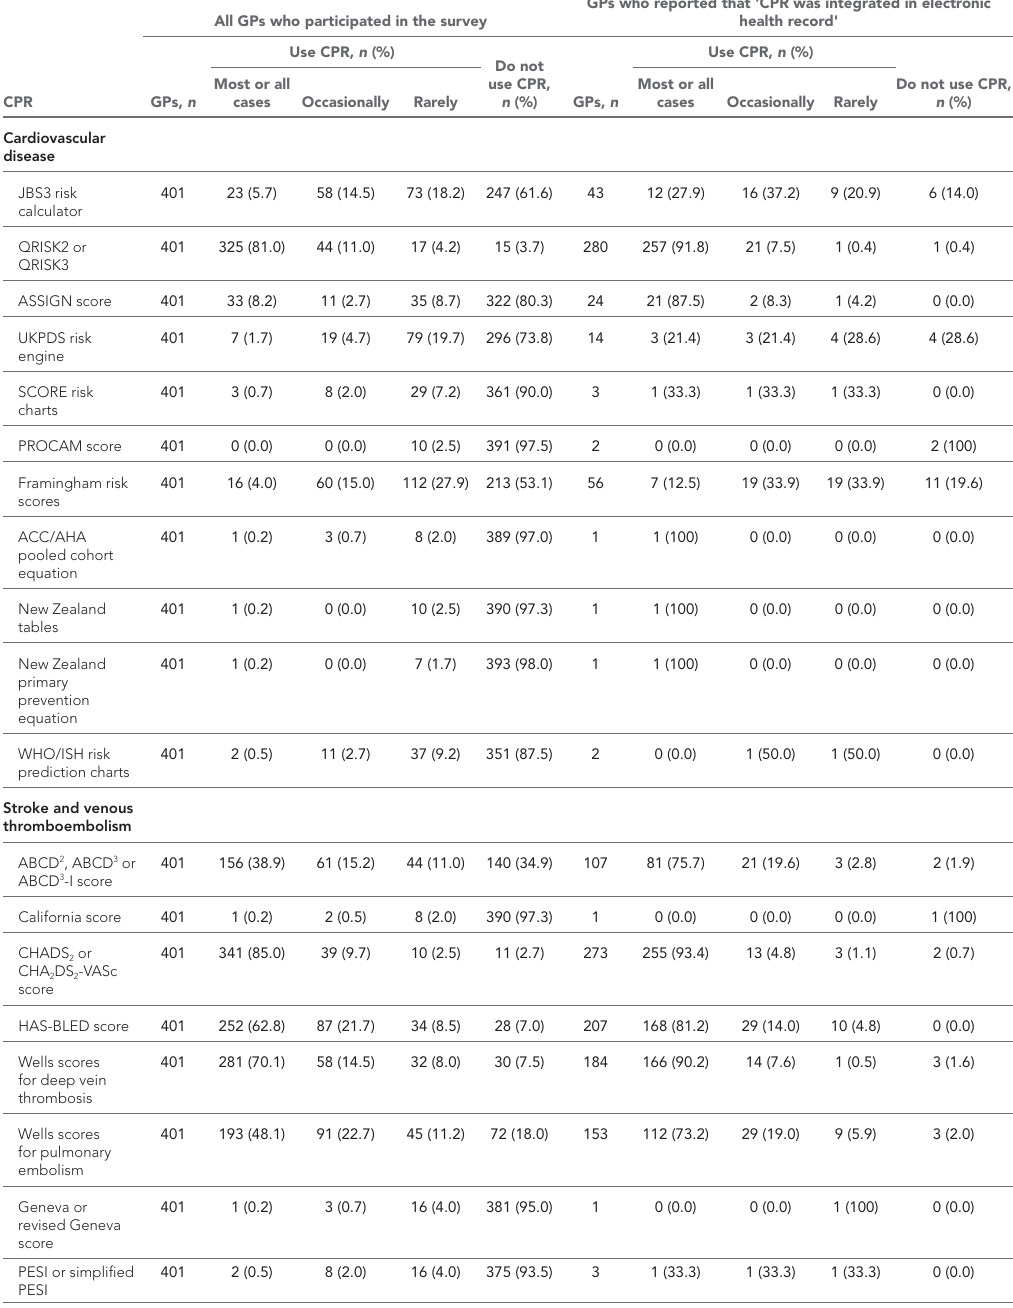
Table 4 Frequency of using cardiovascular clinical prediction rules by all GPs who participated and GPs who reported that CPR was integrated in electronic health record All GPs who participated in the